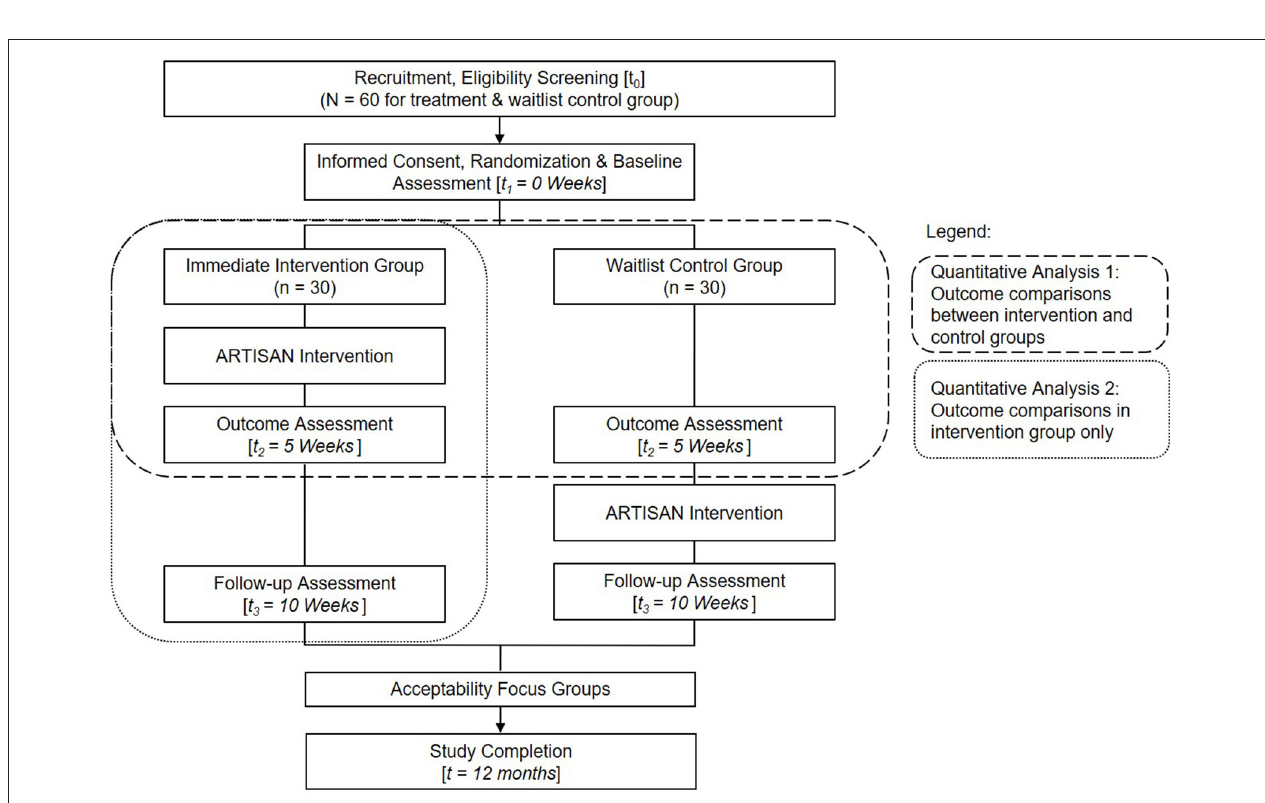
FIGURE 2 | Study flow